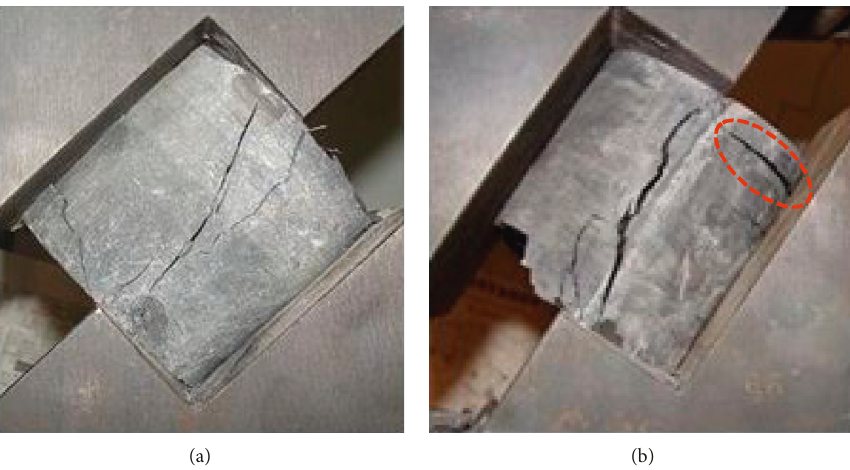
Figure 5: Fracture styles of mudstone specimens under coupled compression and shear. (a) 45 ° (No. 2 sample). (b) 55 ° (No. 1